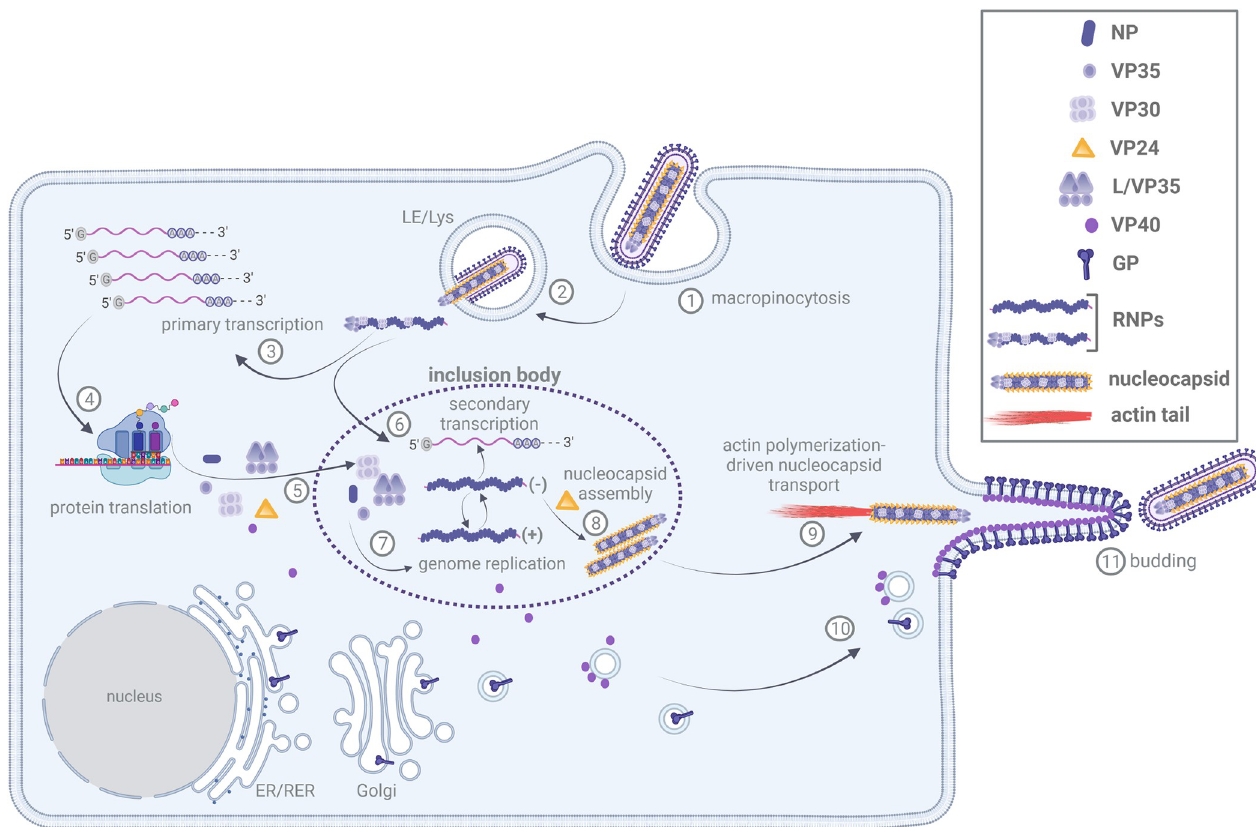
Fig 1. Filovirus replication cycle. AU : AbbreviationlistshavebeencompiledforthoseusedinFigs 1 (cid:0) 4 : Pleaseverifythatallentriesarecorrect : Viral entry into target cells is initiated after attachment to the plasma membrane and is accomplished by macropinocytosis (1). During maturation of macropinocytic vesicles into LE/Lys, the viral envelope fuses with the LE/Lys membrane, and the NC is released into the cytosol (2), where it serves as a template for the primary transcription of capped viral mRNAs (3). Translation of viral proteins (4) occurs at free ribosomes, with the exception of GP, which is translated at the rough endoplasmatic reticulum (ER/RER). GP is transported through the classical secretory pathway via the Golgi apparatus to the plasma membrane. The matrix protein VP40 associates with membrane vesicles and is transported to the plasma membrane to form the viral envelope together with GP and cellular lipids (10). Expression of NC proteins (NP, VP35, VP30, VP24, and L) leads to the formation of IBs (5) where secondary transcription (6), genome replication (7), and NC assembly are organized (8). NCs are transported directionally from IBs to budding sites through actin polymerization-driven transport mediated by actin tail formation at one end (9). Envelopment of NCs by membranes containing VP40 and GP occurs at the plasma membrane where budding of filoviruses take place (11). Figure was created with BioRender.com. IB, inclusion body; LE/Lys, late endosomes/lysosomes; RER, rough endoplasmatic reticulum; RNP, ribonucleoprotein complex.